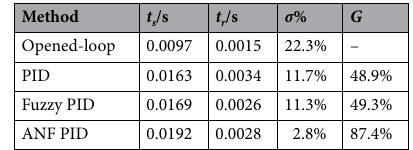
Table 6. Evaluation of small signal model.